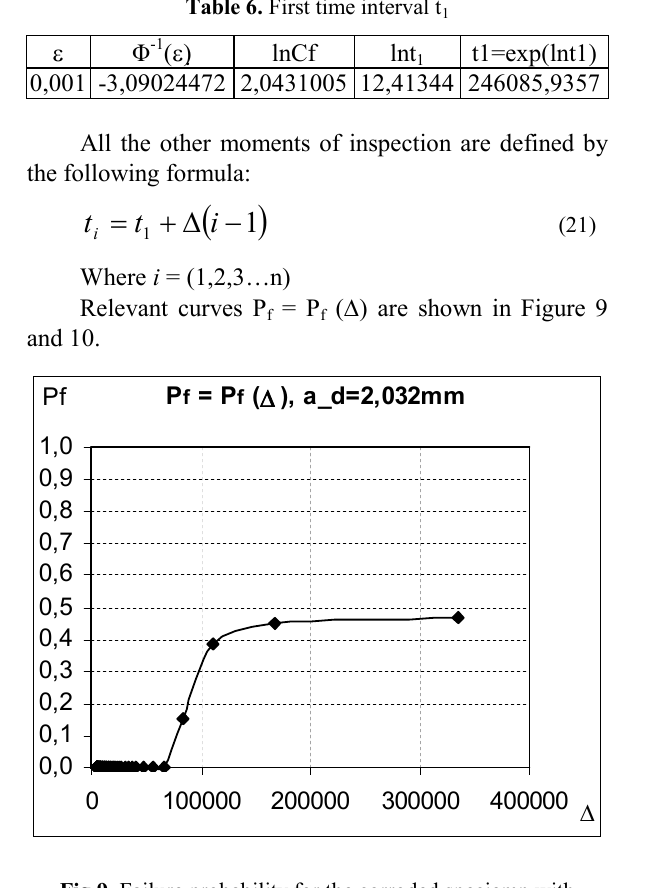
Fig 9 . Failure probability for the corroded speciemn with specified life = 450000 cycles